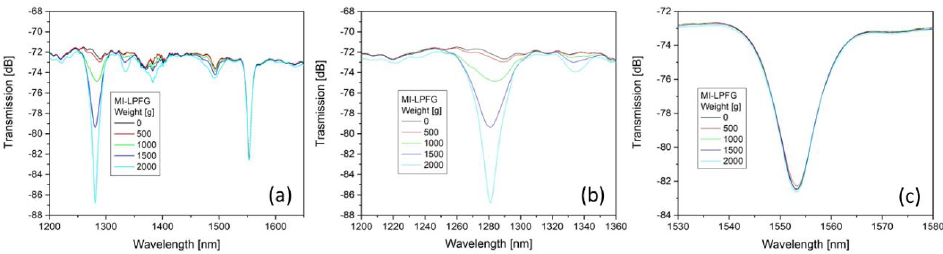
Figure 3. The transmission spectrum of ( a ) multiplexed LPFGs, ( b ) MI-LPFG, ( c ) CO 2 LPFG versus applied weight on the MI-LPFG.